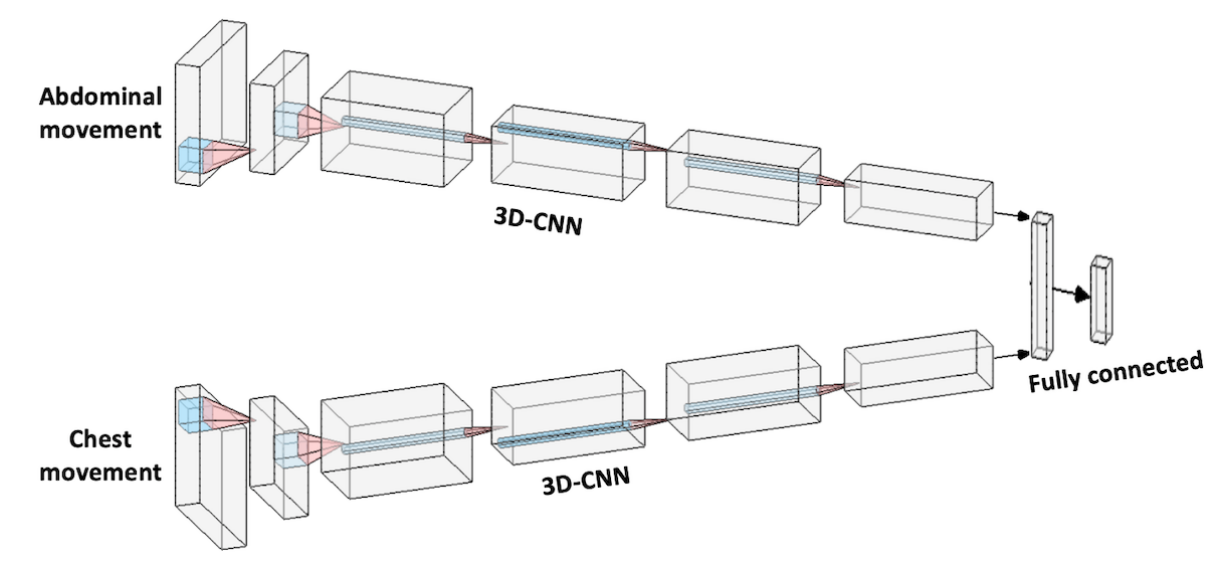
Figure 2. The Convolutional neural network architecture used to extract and combine information from movements of the chest and the